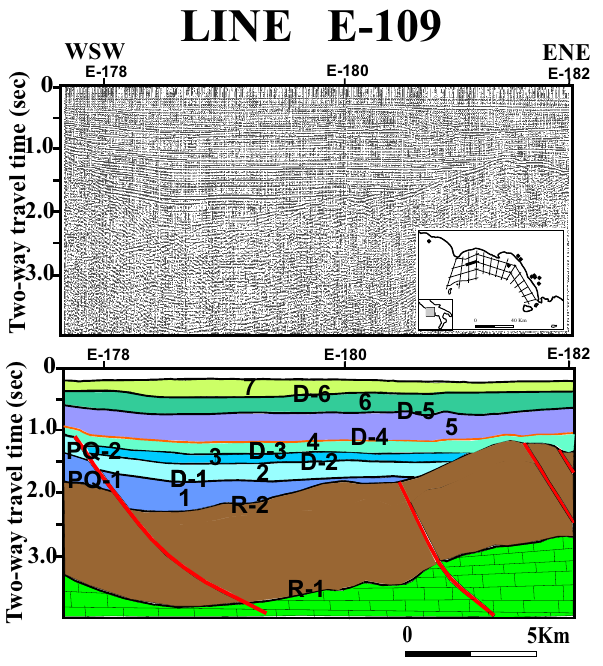
Figure 8. E109 seismic profile (re-interpreted from Aiello et al. [2000]) across the Terracina–Gaeta basin margin. Regional unconformities: R-1, R-2, D-1, D-2, D-3, D-4, D-5 and D-6. Seismic units: 1, 2, 3, 4, 5, 6, 7. Note the master fault, strongly down-throwing the Meso-Cenozoic acoustic basement (throw of less than 1 s) and controlling the formation of the half-graben.